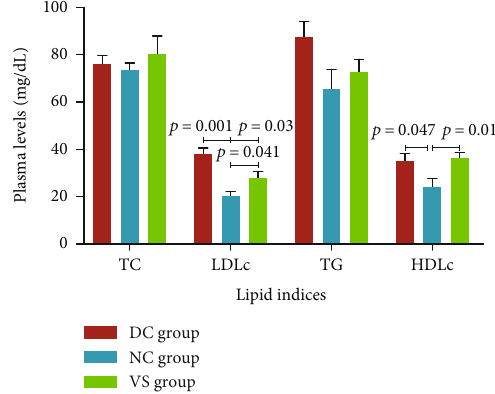
Figure 5: The plasma levels (mg/dL) of total cholesterol (TC), low- density lipoprotein cholesterol (LDL-C), triglyceride (TG), and high-density lipoprotein cholesterol (HDL-C) in the vaccinated STZ-injected rats (the VS group), diabetic control rats (the DC group), and normal control rats (the NC group) at the end of the study. N = 8 . Data are expressed as the mean ± SEM